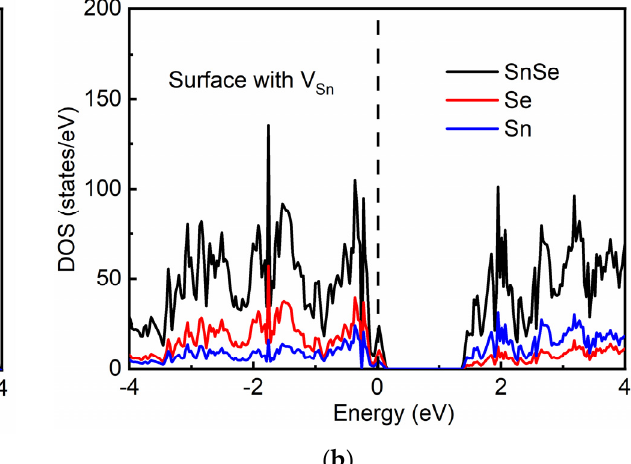
Figure 5. The adsorption Gibbs free energy of H adsorbed on the SnSe monolayer surface. Clean represents the clean SnSe monolayer surface. V Sn represents the SnSe monolayer surface with one Sn defect.